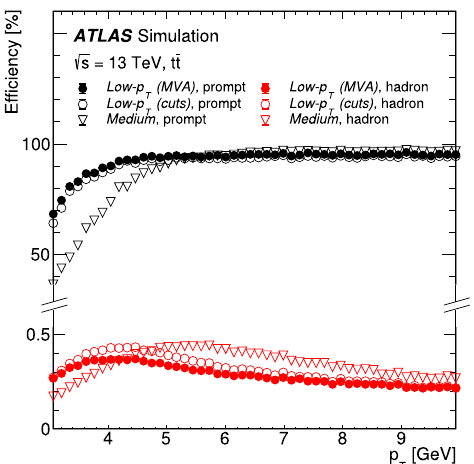
Fig. 4 Efficiency as a function of η (left) and p T (right) of the ID track for the Low - p T and Medium WP requirements in simulated t ¯ t events, shown separately for prompt muons and muons from light hadron decays. The efficiency is calculated as the fraction of ID tracks